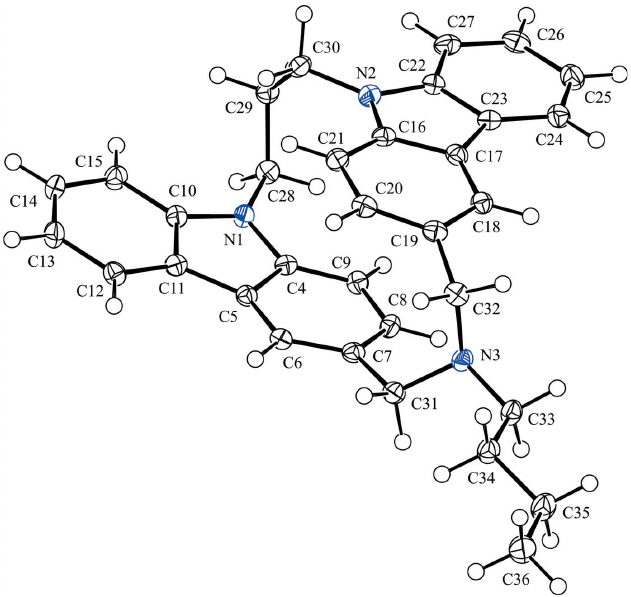
Figure 1 The molecular structure of the title compound with the atom labelling. Displacement ellipsoids are drawn at the 50% probability level. H atoms are represented by spheres of arbitrary radius.